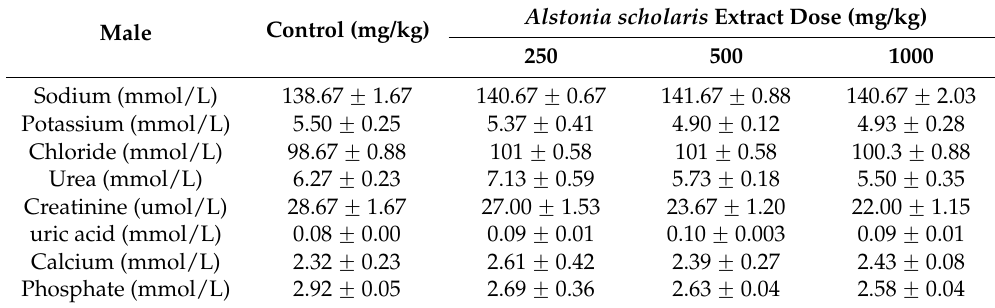
Table 4. Serum electrolytes values of the male rats in the sub-acute toxicity study of the methanolic extract of the bark of Alstonia scholaris. Results were expressed as the mean ˘ S.E.M. of 5 rats.